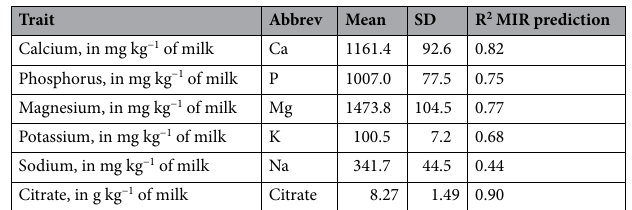
Table 1. Mean, standard deviation (SD), and accuracy (R 2 ), estimated by cross-validation, of mid-infrared (MIR) predictions for concentrations of minerals and citrate in milk from Montbéliarde cows.